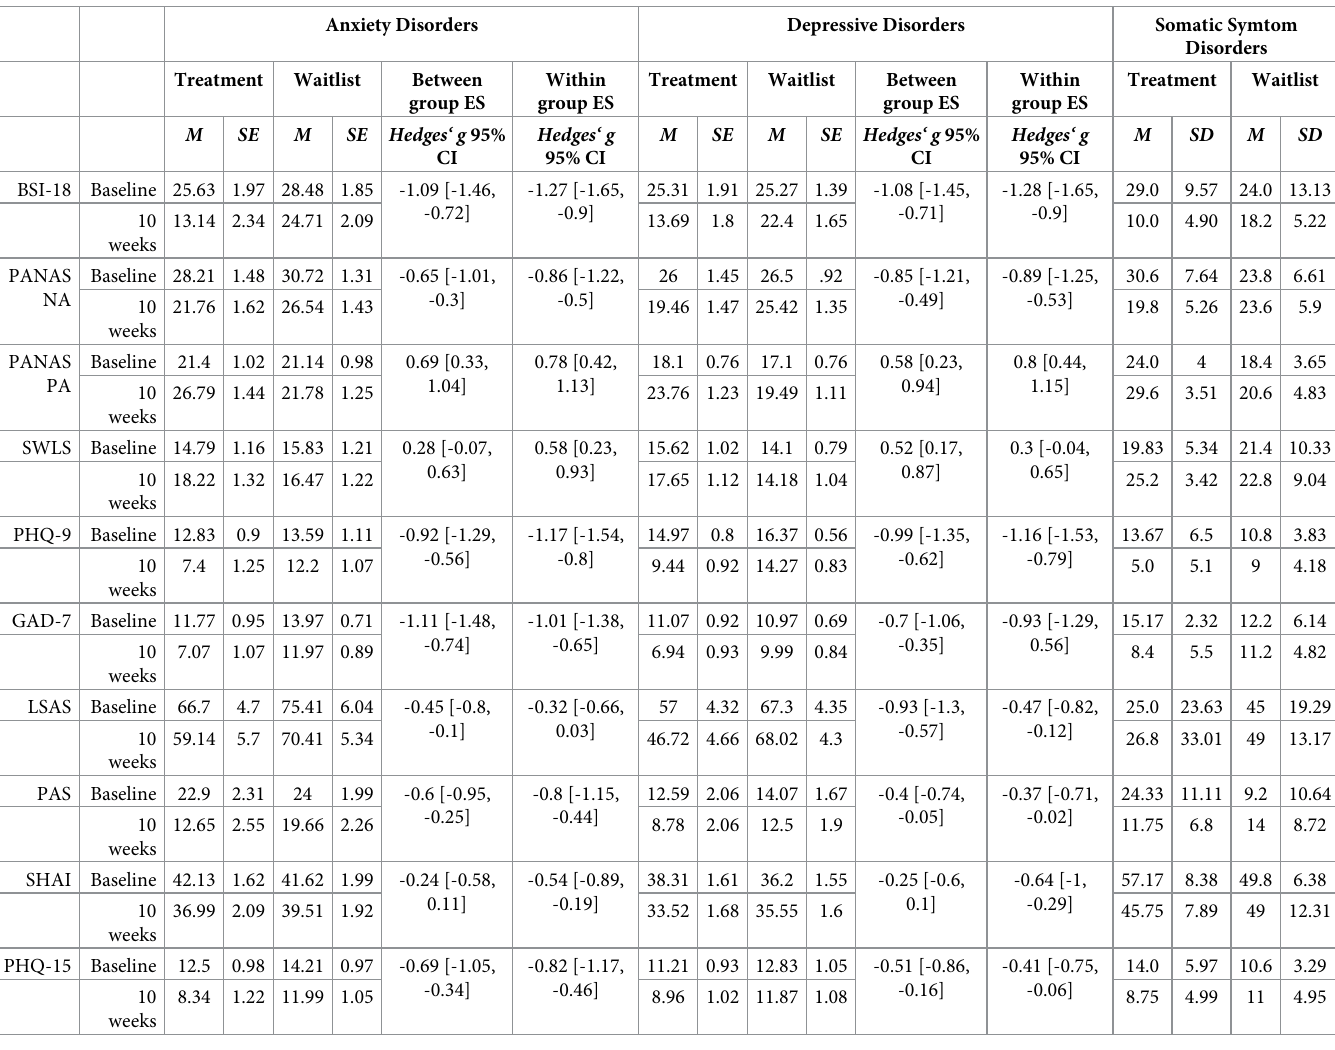
Table 5. Means in primary anxiety, depressive and somatic symptom disorders subsamples and effect sizes in anxious and depressive